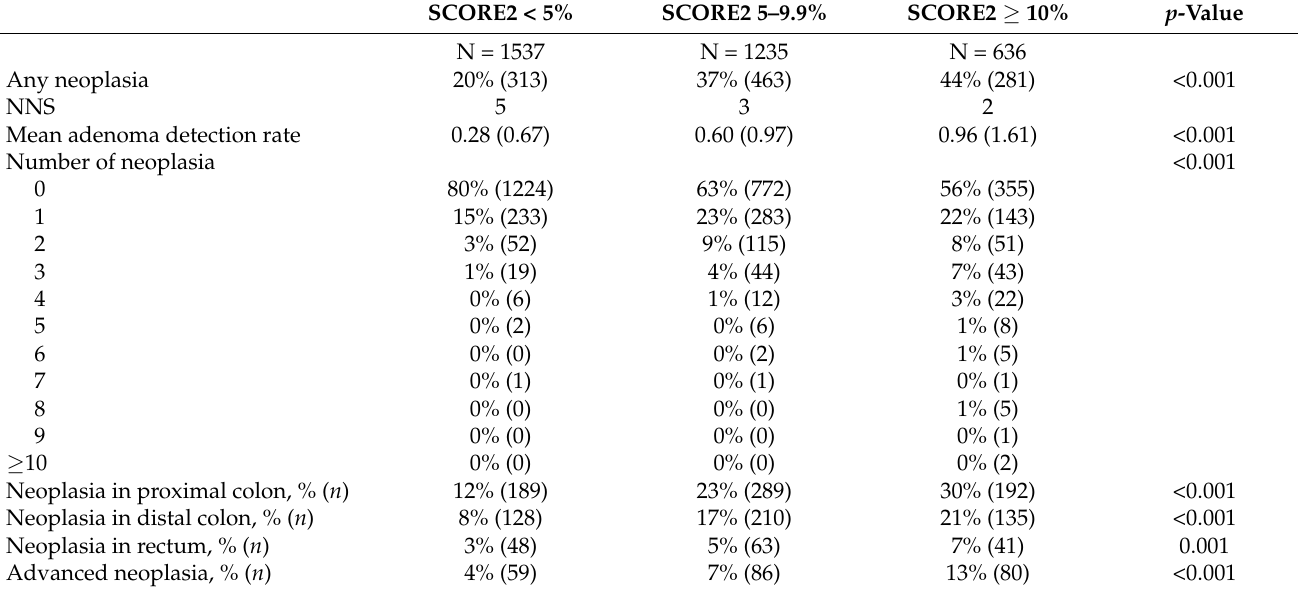
Table 2. Any colorectal neoplasia and advanced colorectal neoplasia detection rates according to SCORE2 level. Abbreviation: NNS—number needed to